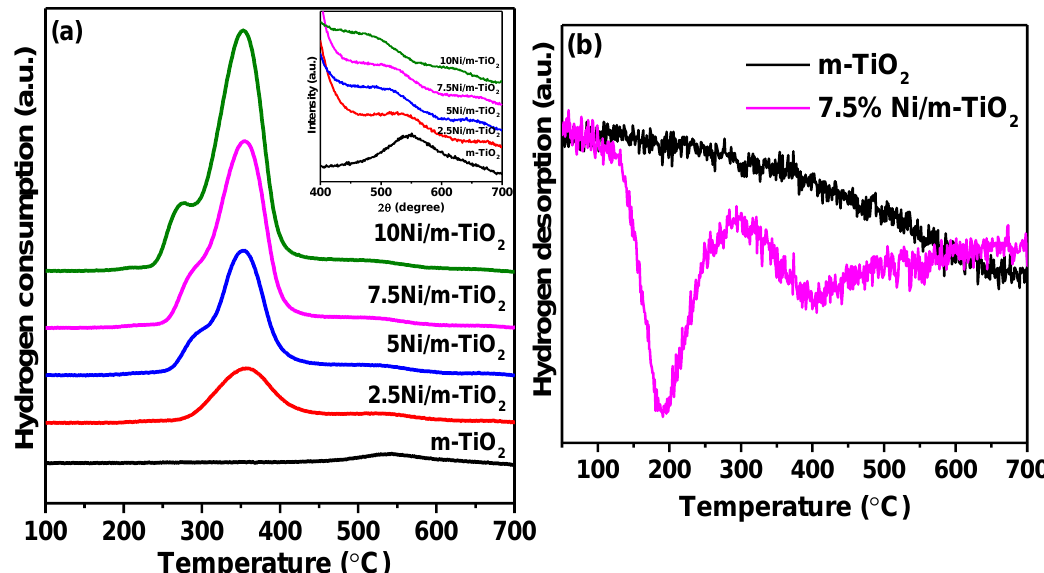
Figure 5. ( a ) H 2 -TPR profile of xNi/m-TiO 2 catalysts, ( b ) H 2 -TPD profile of m-TiO 2 and 7.5Ni/m-TiO 2 catalysts. Table 1. Ni loading and properties of xNi/m-TiO 2 catalysts.